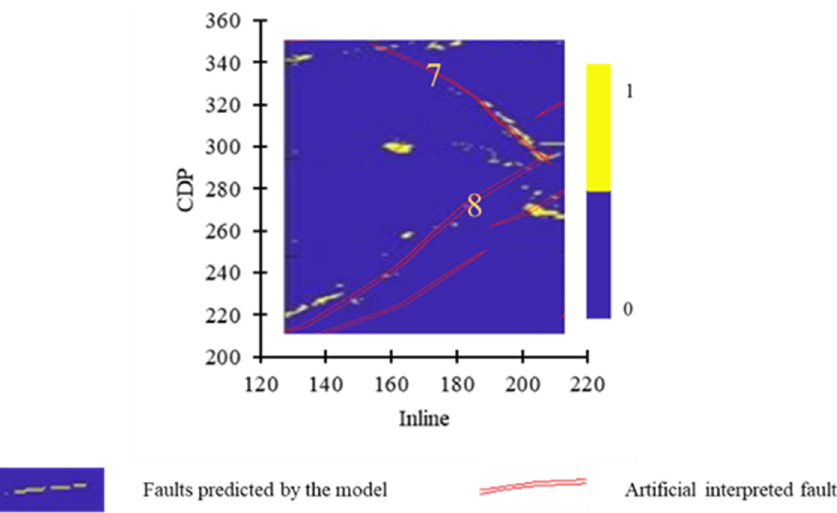
Energies 2022 , 14 , x FOR PEER REVIEW Figure 15. The prediction result of Faults 7–8 by Region A as training set. Figure 15. The prediction result of Faults 7–8 by Region A as training set. Figure 15. The prediction result of Faults 7–8 by Region A as training set.